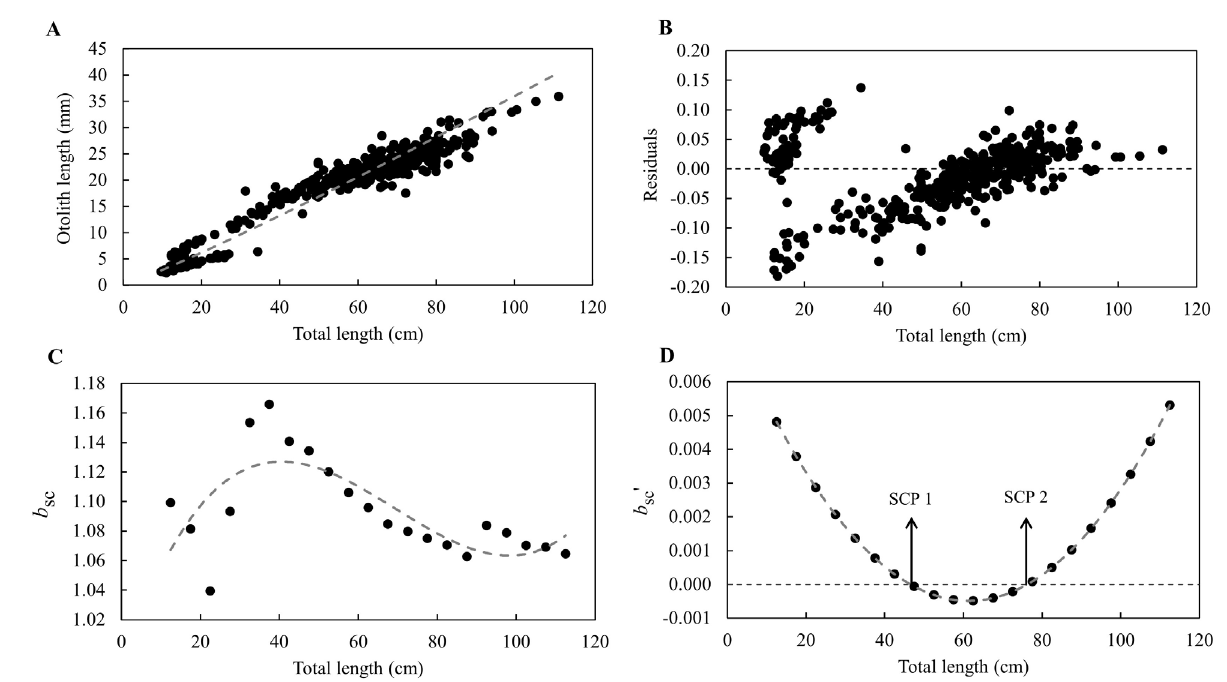
FIGURE 3 | Growth changes in Centropomus undecimalis based on a polyphasic growth model. A. Potential regression for fish total length as a function of otolith radius; B. Residual distribution; C. Exponential coefficient ( b sc) for length class; D. Derivative of the third-degree polynomial function, and indication of the change points of the stanza (SCP 1 and SCP